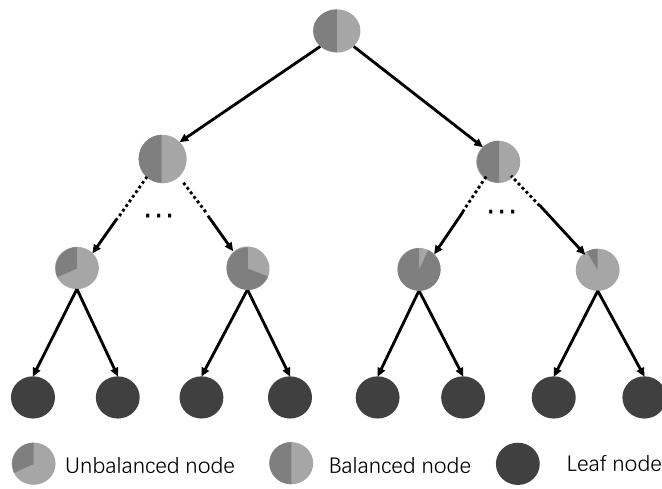
Figure 5. An example of a decision tree structure in the backtracking regression forest. The leaf nodes are depicted as a pie chart to illustrate the proportion of samples. More details can be found in